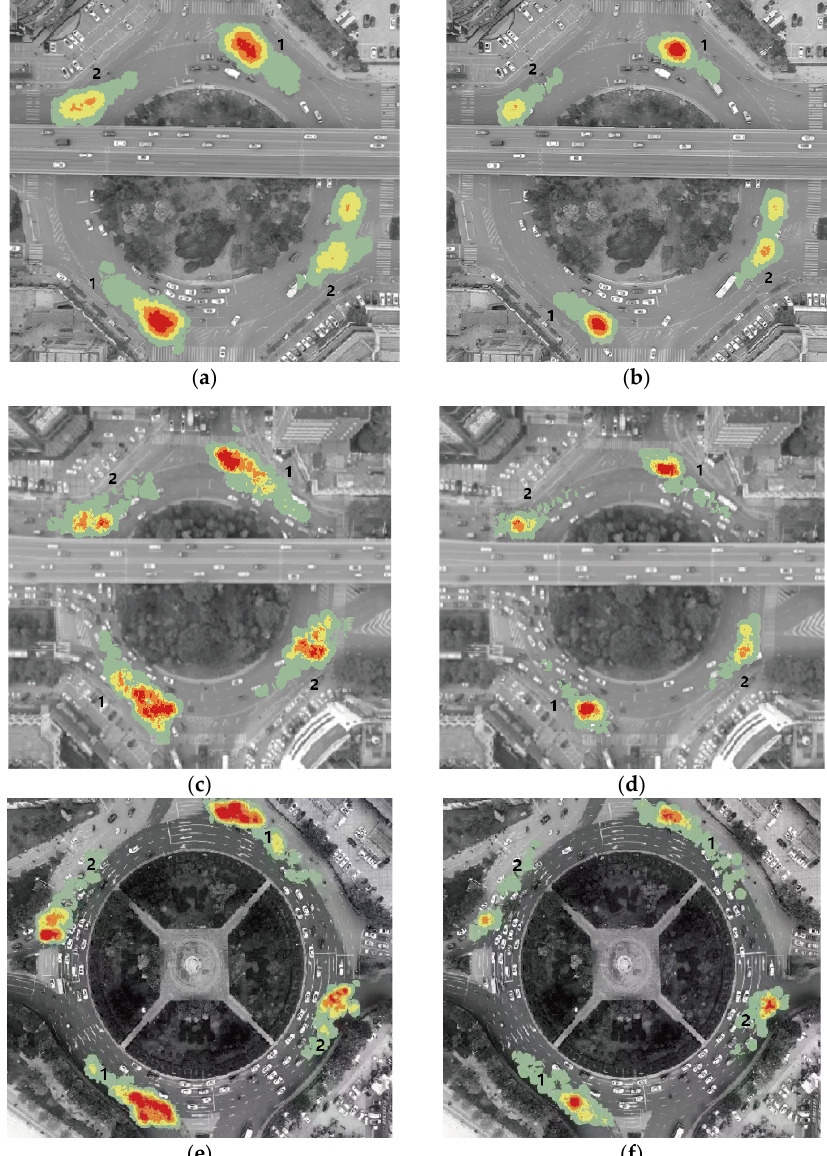
Figure 11. Conflict distribution heat maps. ( a ) Distribution of general conflicts (Zhuque); ( b ) Distribution of serious conflicts (Zhuque); ( c ) Distribution of general conflicts (Han-guang); ( d ) Distribution of serious conflicts (Han-guang); ( e ) Distribution of general conflicts (Chen-yangzhai); ( f ) Distribution of serious conflicts (Chen-yangzhai).